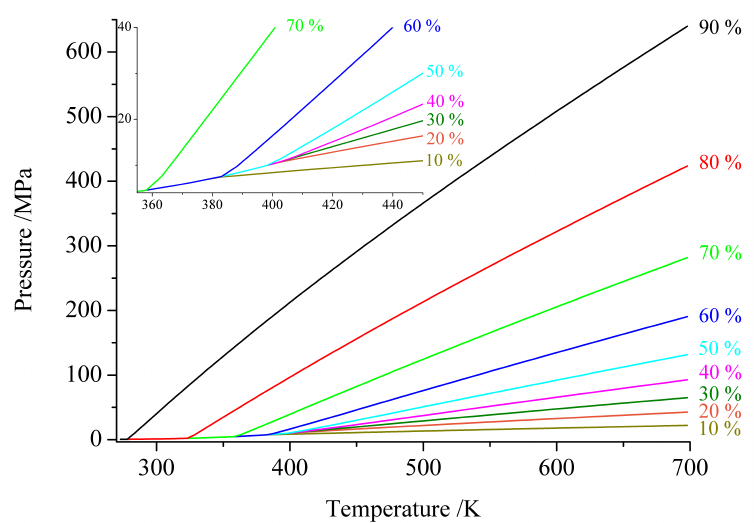
Figure 2. Pressure-temperature diagram of ammonia in dependence on the filling degree of the reaction vessel (in %). The inset shows an enlarged view in the range around the critical point ( T 405.2 K, p = 11.3 K) crit. crit.